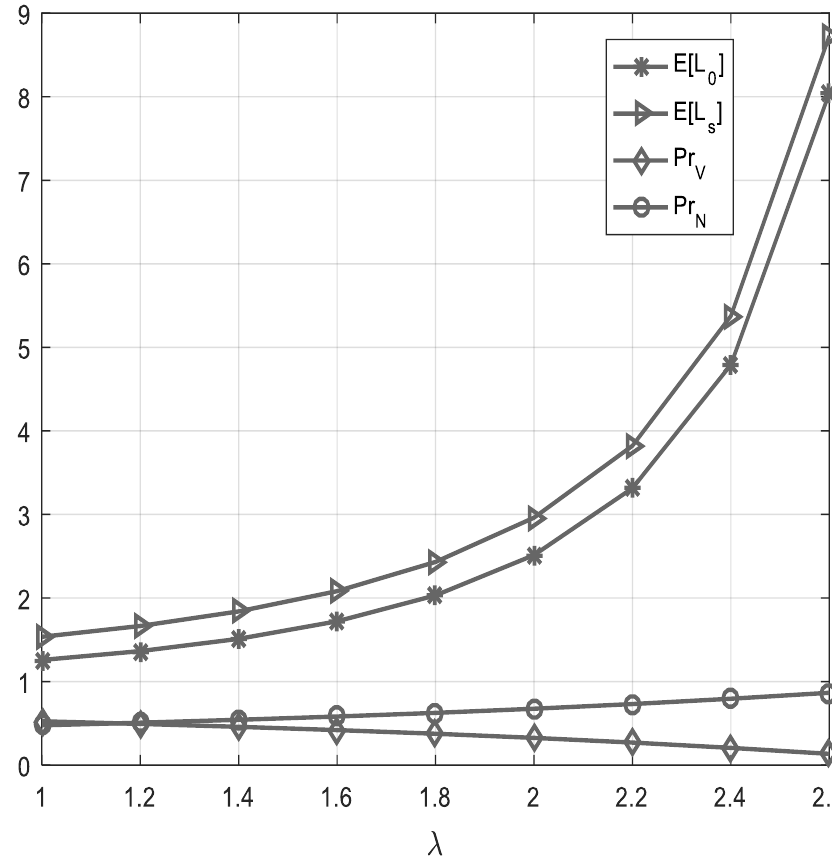
Figure1. Effect of active state arrival rate (λ) on system performance measures.